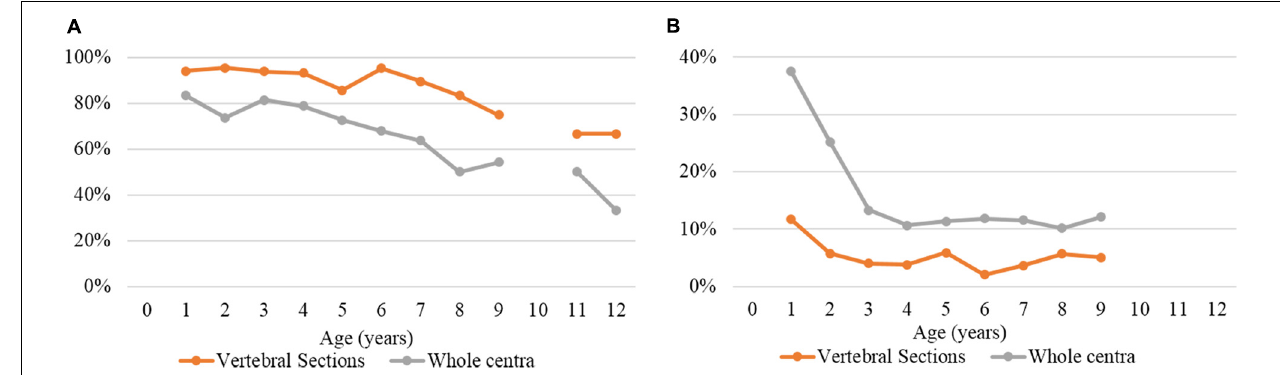
FIGURE 6 | (A) Percentage of agreement and (B) coefficient of variation by age group and preparation method.